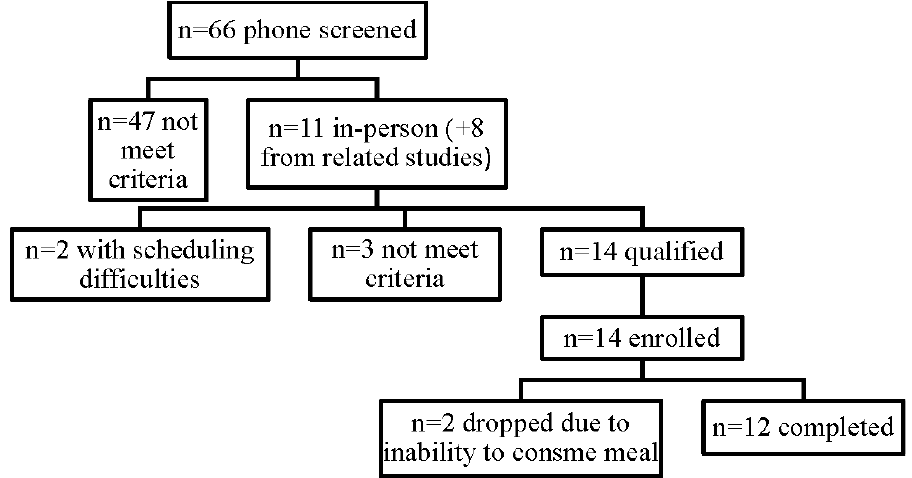
Figure 1. Participant Flow.